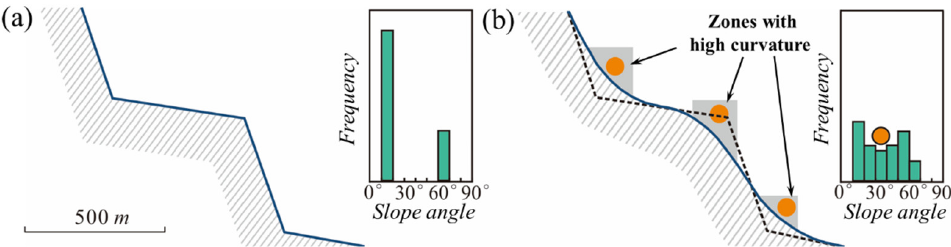
Figure 8. Illustration of the SAD method [27]. ( a ) Ideal profile of a valley profile consisting of two MUs (footslope and cliff) and its corresponding SAD. ( b ) Realistic profile of a valley profile and its corresponding